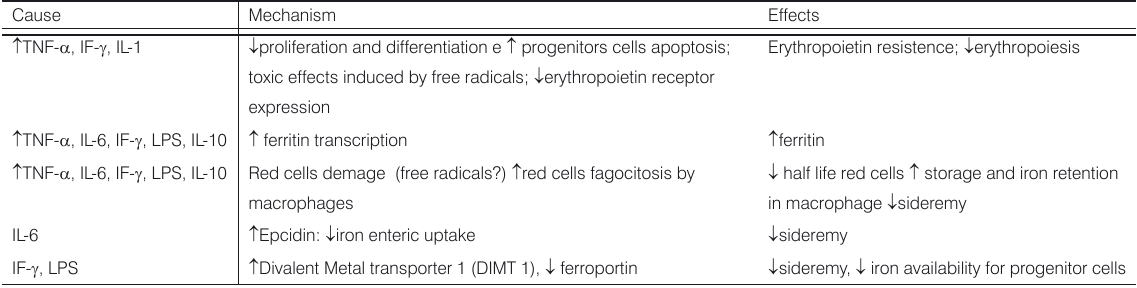
Table 3. Effects of cytochines on iron metabolism and